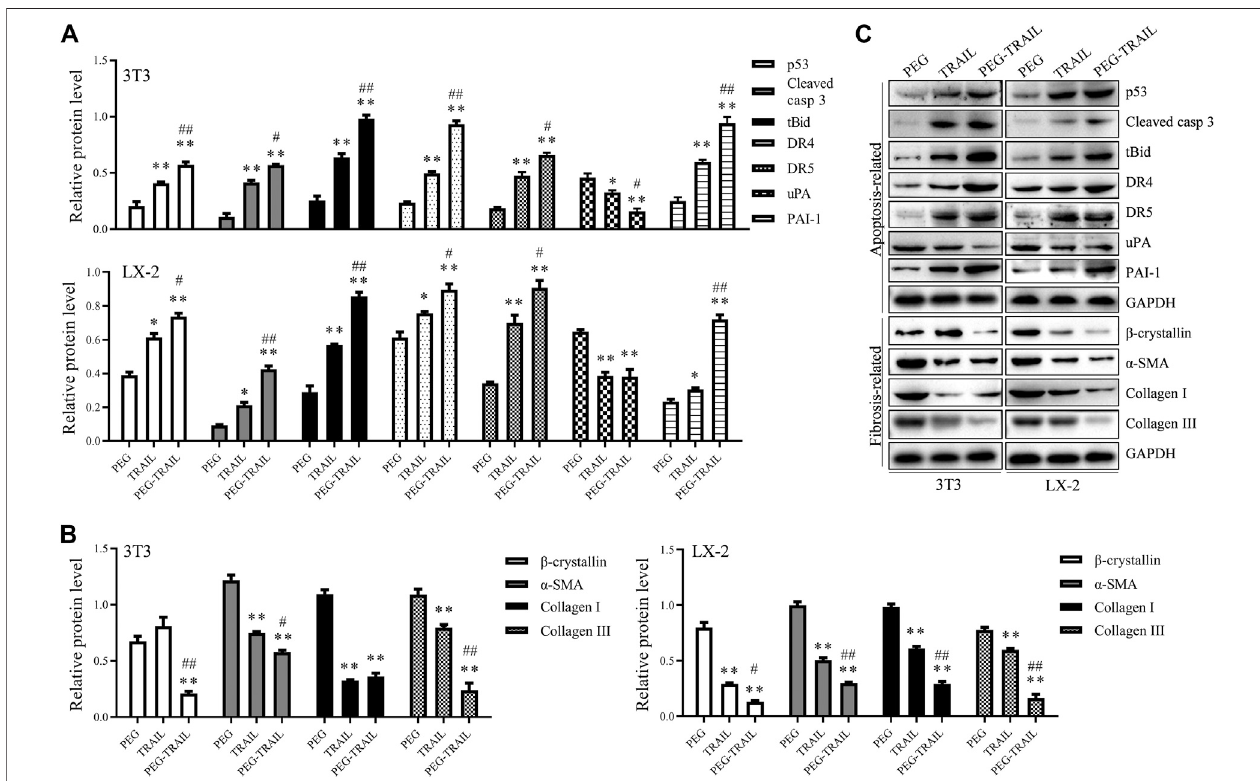
FIGURE2| PEG-TRAILalterstheproteinexpressionofapoptosis-and fi brosis-relatedgenesin3T3andLX-2cells. (A) Therelativeproteinlevelofp53,cleavedcaspase-3, tBid, DR4, DR5, uPA, and PAI-1 normalized toGAPDH; (B) The relative protein level of β -crystallin, α -SMA, collagen I, and collagen III normalized to GAPDH; (C) Representative blots for each protein measured with Western blotting from triplicate results. * p < 0.05 and ** p < 0.01 compared with PEG; # p < 0.05 and ## p < 0.01 compared with TRAIL.